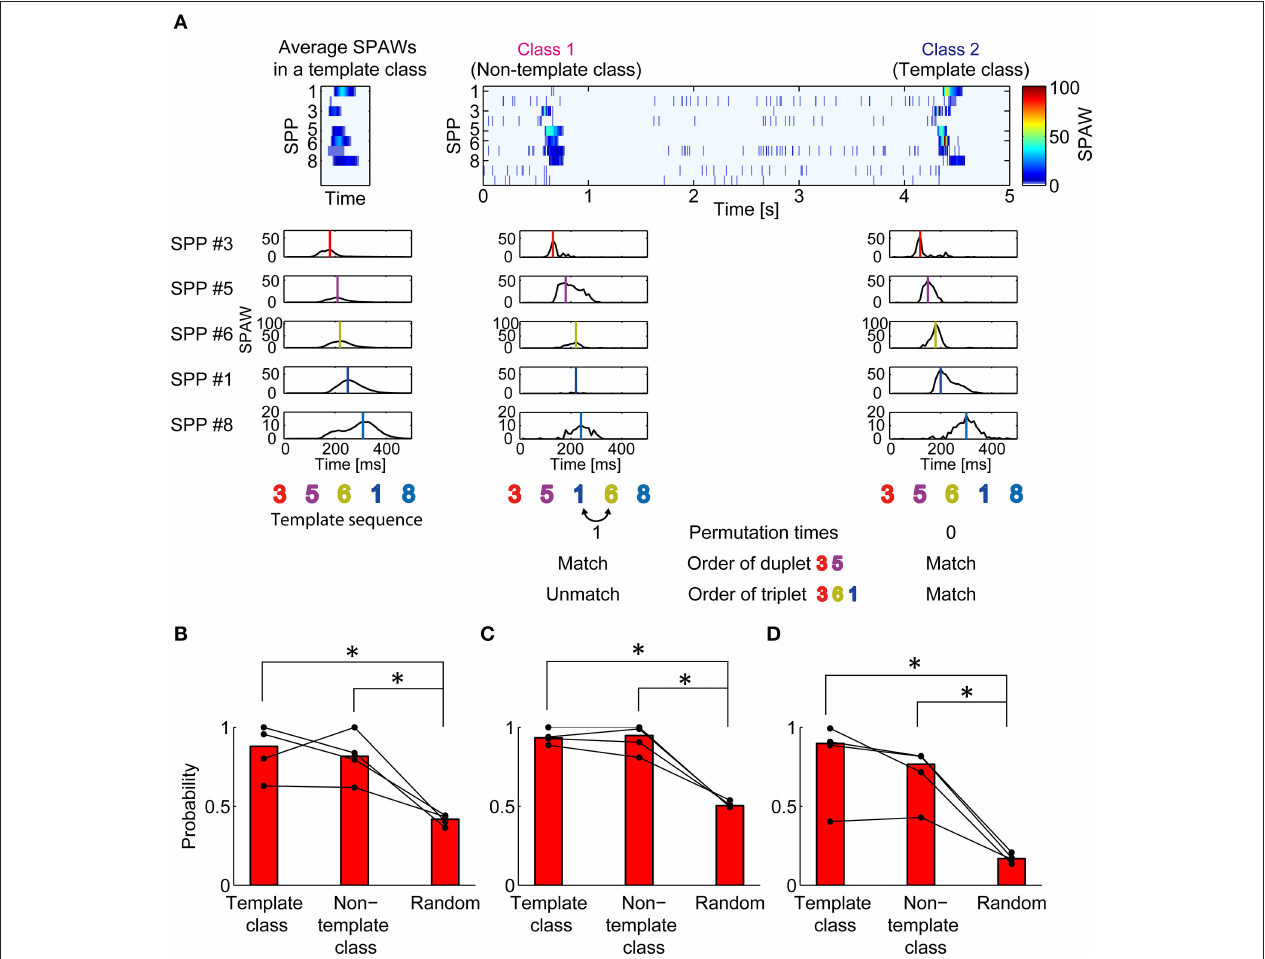
FIGURE 3 | Similarity in partial sequence of sub-population activation between synchronized burst classes. (A) Illustration of the procedure to evaluate partial similarity between sub-population sequences of bursts. SPAWs during a burst were converted into a sequence of their peaks. Sub-population sequences of bursts were compared with the template sequence. Permutation times for matching refers to the way in which many pair permutations are required to match the template sequence. Duplet/triplet order matching indicates whether the order of two/three sub-populations matches the template sequence. (B) Probability that permutation times for matching is two or less. (C,D) Probability that the duplet (C) or the triplet (D) order matched the template. The most reproduced duplet or triplet was selected for analysis. The Mann–Whitney U -test. * p < 0.05 .